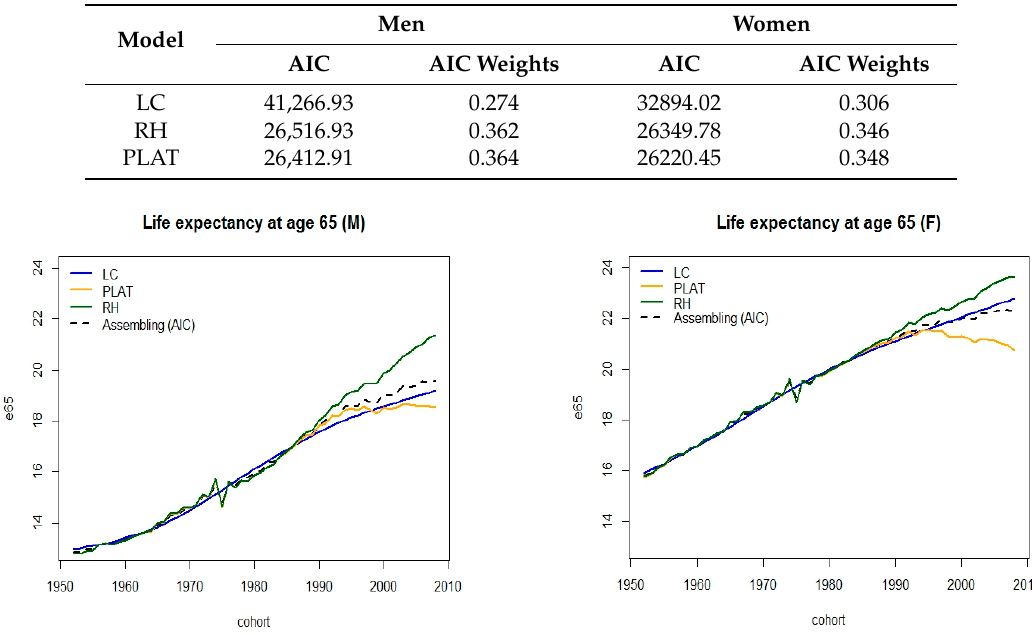
Table 1. Fitting results for the selected mortality models.